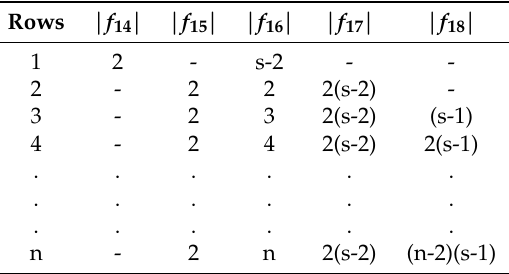
Table 2. Numbers of f 14 , f 15 , f 16 , f 17 , f 18 in each row.